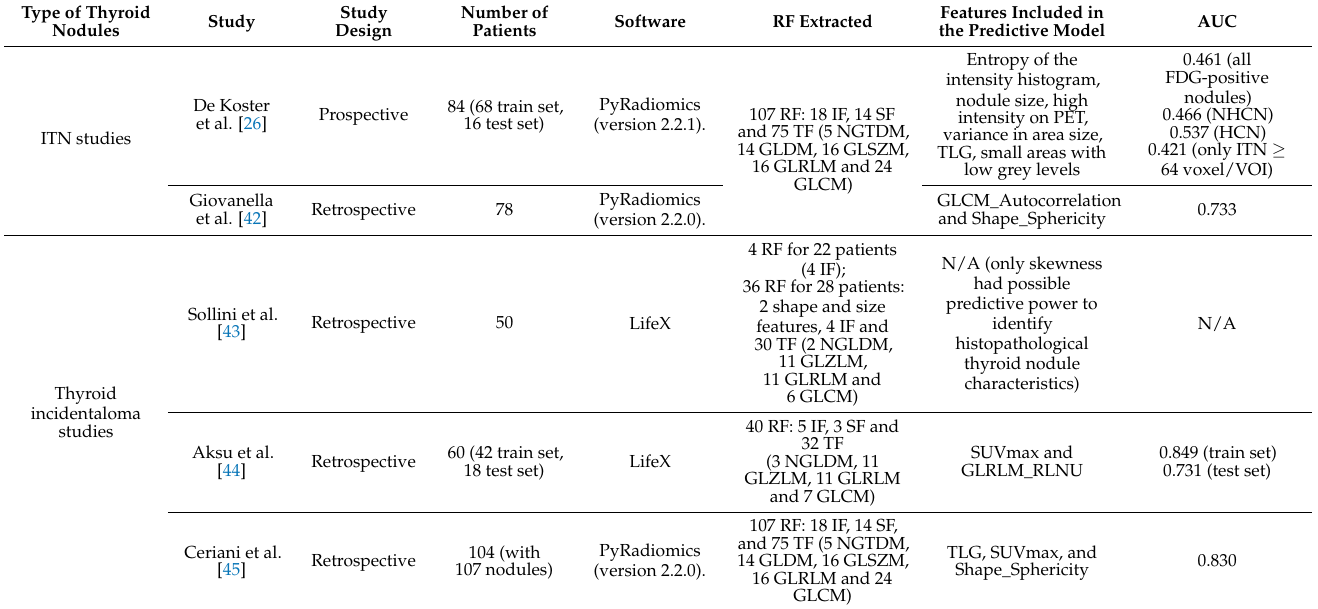
Table 3. Studies that relied on radiomics to determine thyroid nodule histopathological